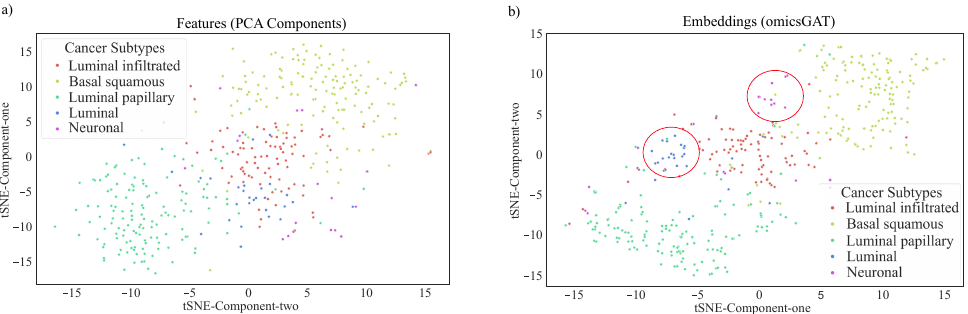
Figure 3. tSNE plots of the ( a ) PCA components generated from the BLCA data and ( b ) omicsGAT- generated embeddings for bladder cancer patients